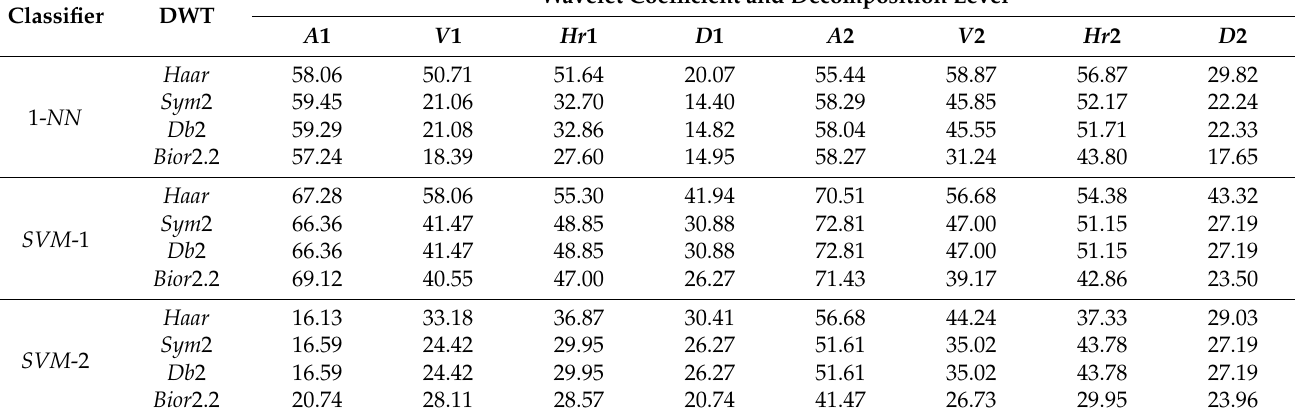
Table 5. The accuracy (%) results of the DWT on the EYB dataset for the eye images. The performance was calculated for all wavelet coefficients in two decomposition levels, producing A 1, V 1, Hr 1, D 1, A 1, V 2, Hr 2, and D